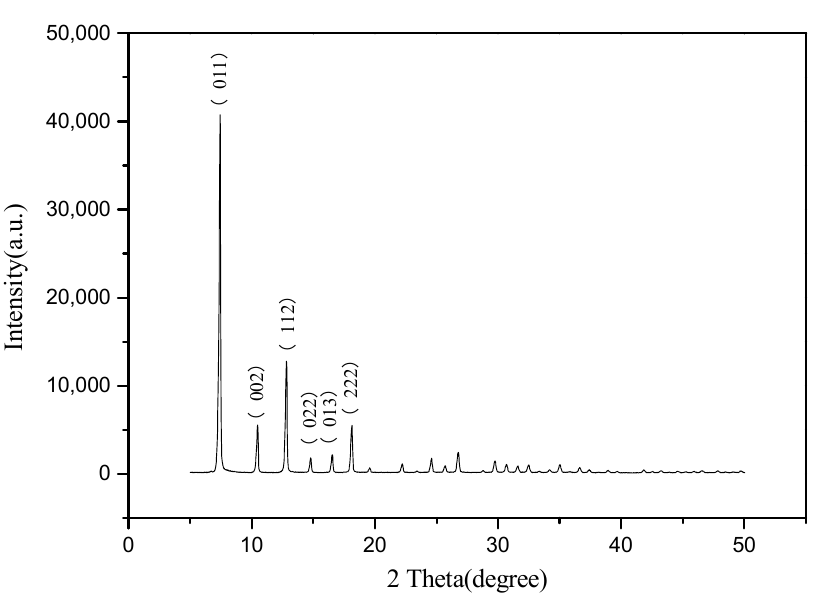
Figure 1. FT−IR spectra of ZIF-8. It can be seen from Figure 2 that the characteristic diffraction peaks of ZIF-8 at (011), (002), (112), (022), (013) and (222) of the synthesized samples in the present study are con- sistent with those reported in the literature, which indicates that the synthesized samples are pure-phase ZIF-8 with high crystallinity.